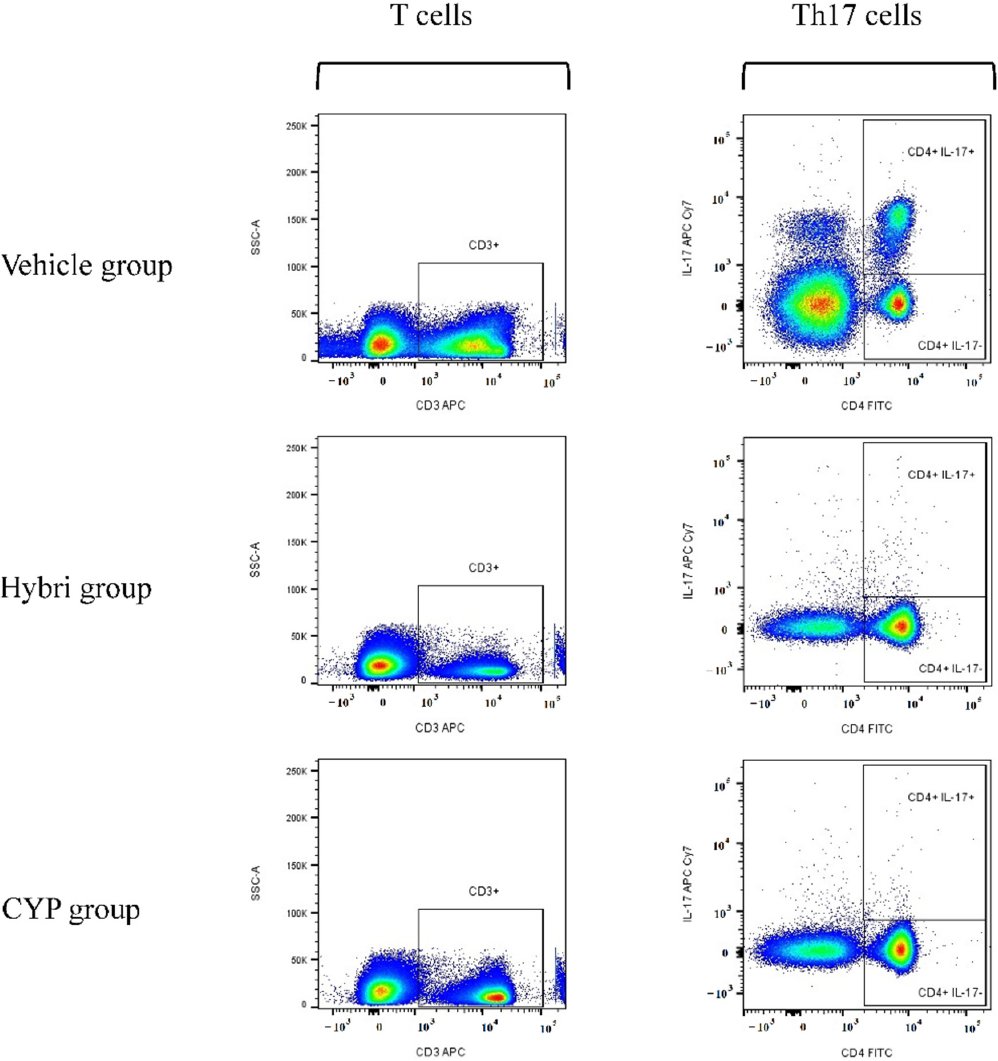
Figure 4. Cumulative graph of Th17 peripheral blood cell analysis at the end of the study, at 36 weeks of age, using flow cytometry software FlowJo ™ v10.8.1. Pseudocolor density plot where blue and green correspond to areas of lower cell density, yellow correspond to mid-range and orange and red are areas of high cell density. CD4 + IL-17 + population is overexpressed in the vehicle group. Gating strategy for Th17 cells: Obtained events were gated on an FSC intensity and FSC peak dot plot to eliminate doublets. Mononuclear cells were gated on an FSC and SSC dot plot. Lymphocytes were gated on an SSC vs. CD3 dot plot. CD4 and IL-17 dot plot was used to separate CD4 cells with and without IL-17 expression. FSC: Forward scatter, SSC: Side scatter. Down sample of 400,000 events for each group. Vehicle group n = 5, Hybri group n = 9 and CYP group n = 8.